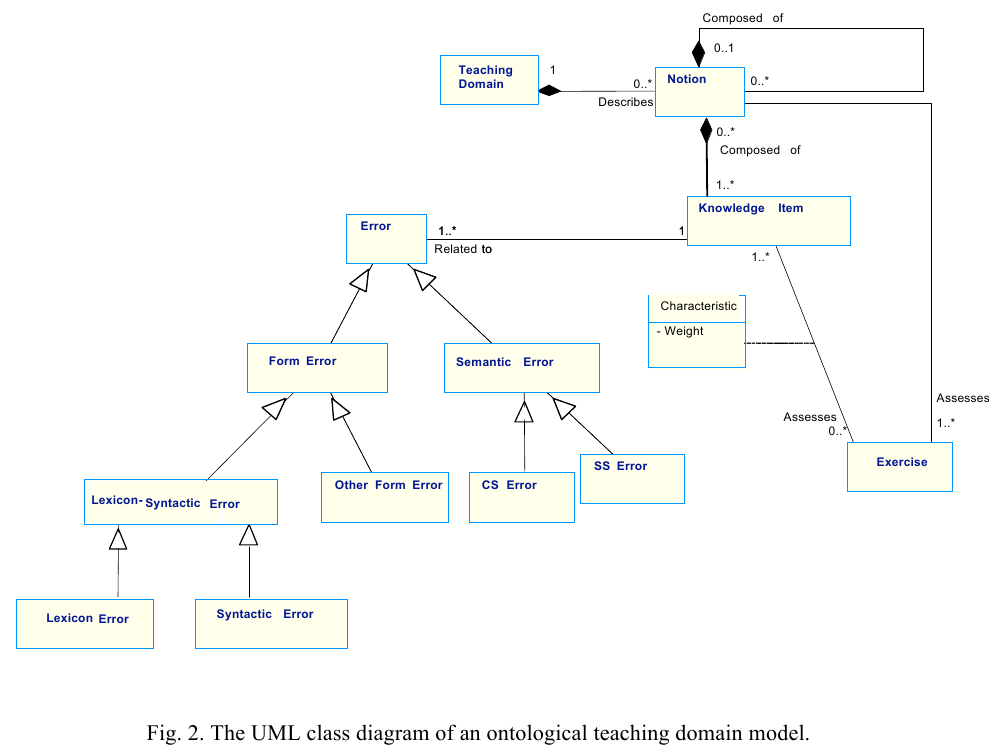
Fig. 2. The UML class diagram of an ontological teaching domain model.